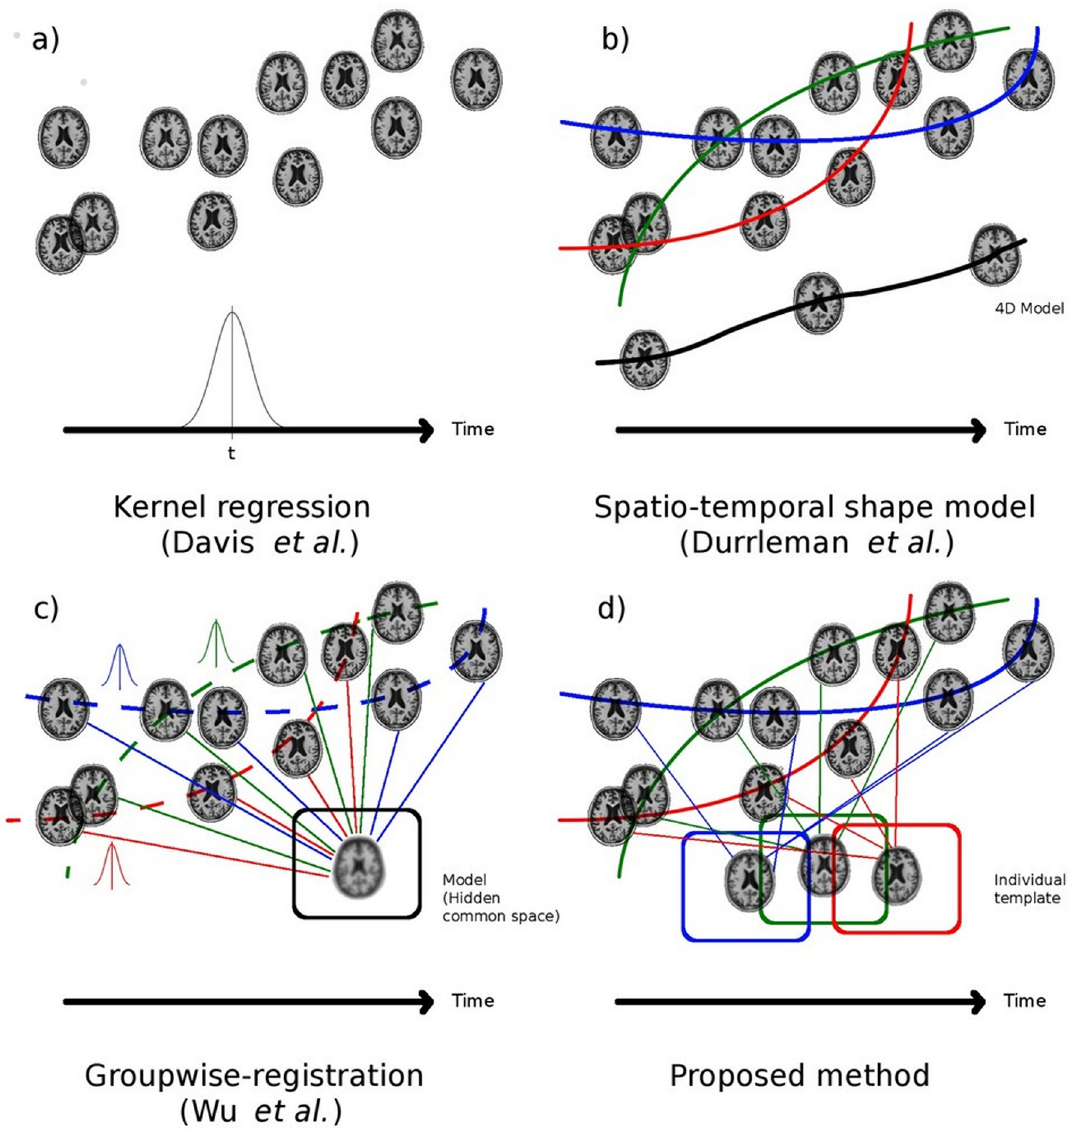
Fig 1. Longitudinal registration and template creation methods. Each vignette (a, b, c and d) represents different strategies proposed to overcome longitudinal MRI data analysis. The x-axis represents the time and the y-axis represents the anatomical variability of the image. Each subject ’ s time-points are connected by a colored line (blue, green and red) and the black line represents a longitudinal (4D) model. The square boxes represent the population 3D template in black and individual 3D templates in blue, green and red.